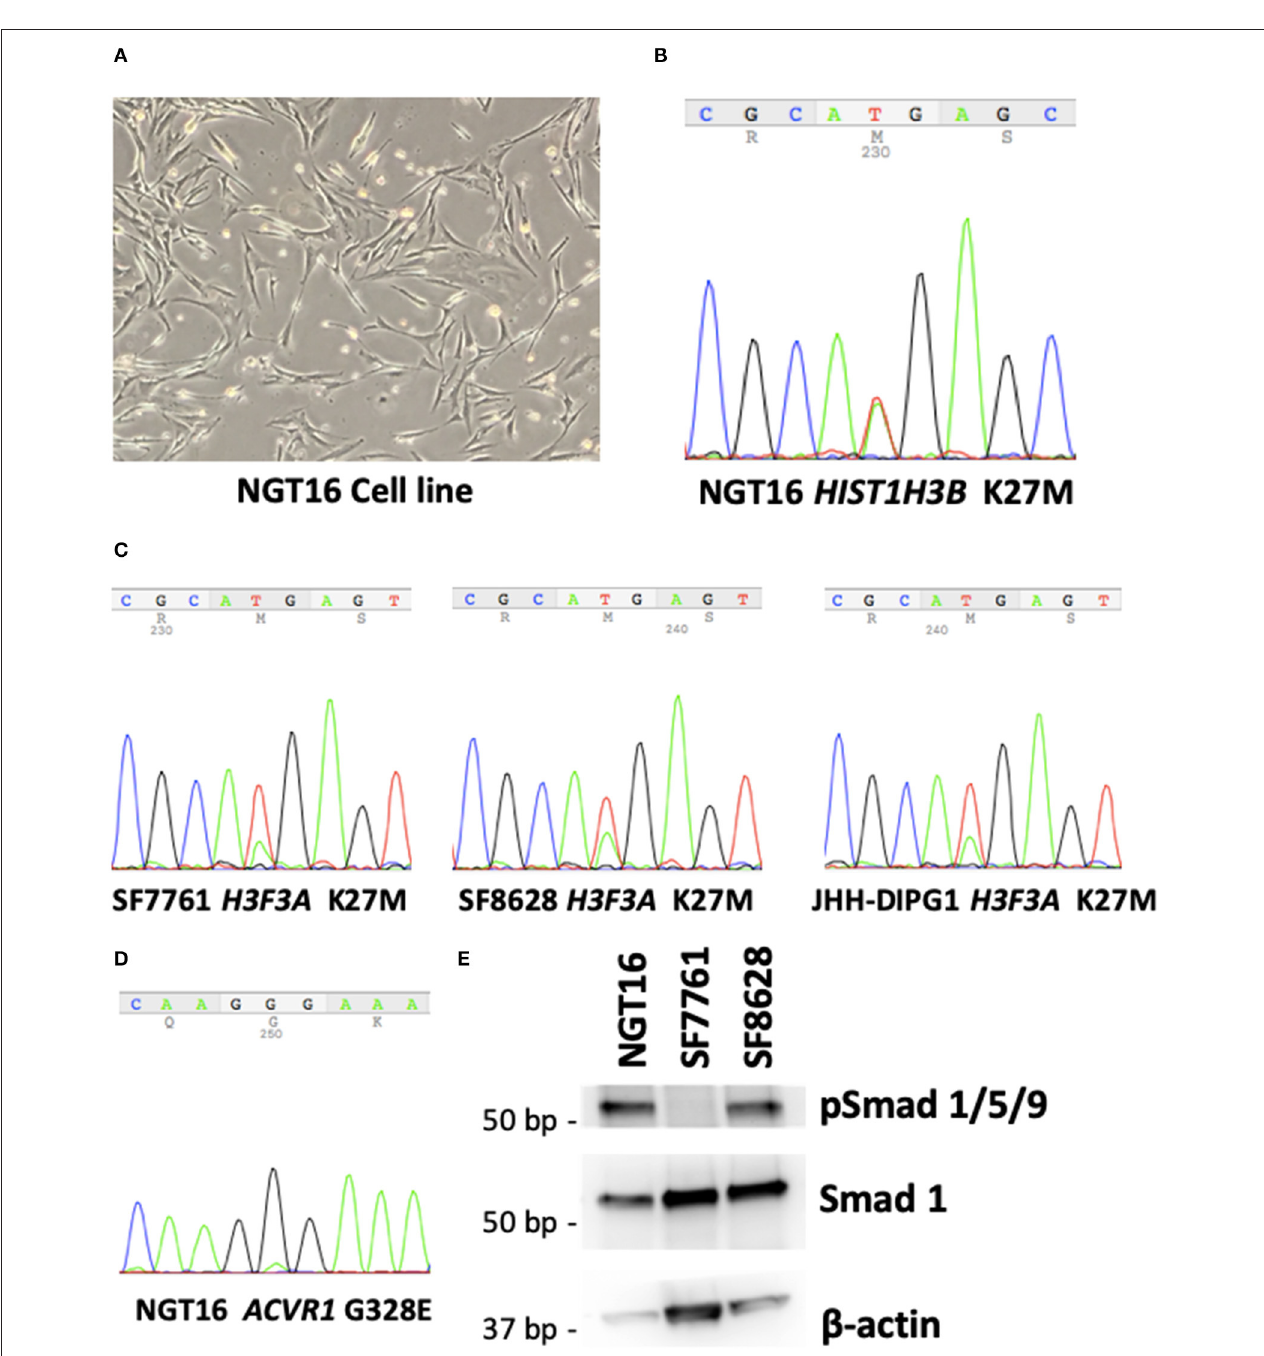
FIGURE 2 | NGT16 harbors HIST1H3B K27M and ACVR1 mutations. (A) NGT16 cell line grows as adherent monolayer in culture. (B) HIST1H3B K27M mutation was confirmed in NGT16. (C) H3F3A K27M mutations were verified in SF7761, SF8628, and JHH-DIPG1 cell lines. (D) ACVR1 G328E mutation was also detected in NGT16, confirming that mutations found in the primary tumor were preserved in the cell line. (E) Downstream activation of the BMP pathway was observed in NGT16 and SF8628 cell lines, but not SF7761.